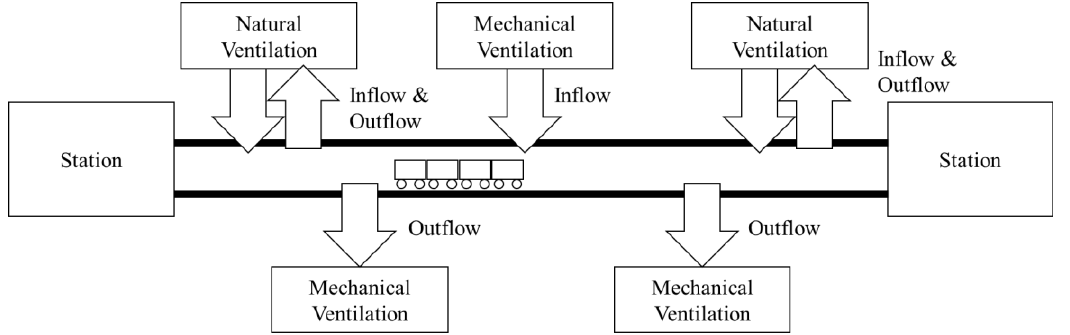
Figure 1. The natural and mechanical ventilation systems in line 4.